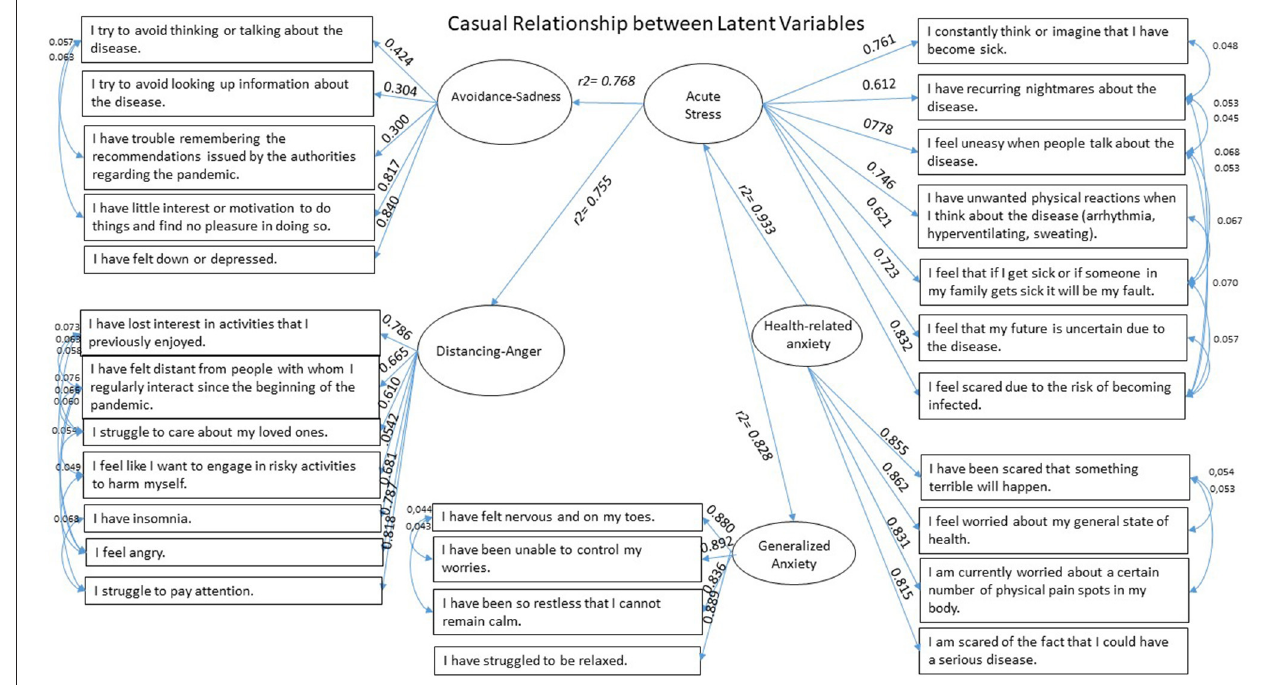
FIGURE 1 | Structural equations model on mental health symptoms: Acute Stress, Avoidance-Sadness, Distancing-Anger, as reported by survey